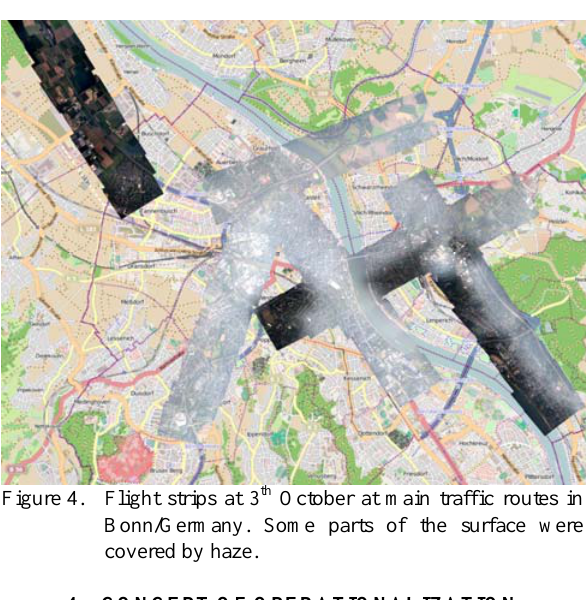
Figure 4. Flight strips at 3 th October at main traffic routes in Bonn/Germany. Some parts of the surface were covered by haze.